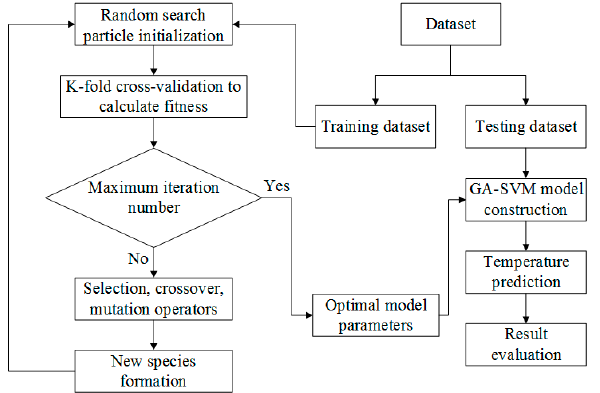
Figure 8. Flow diagram of the GA-SVM.